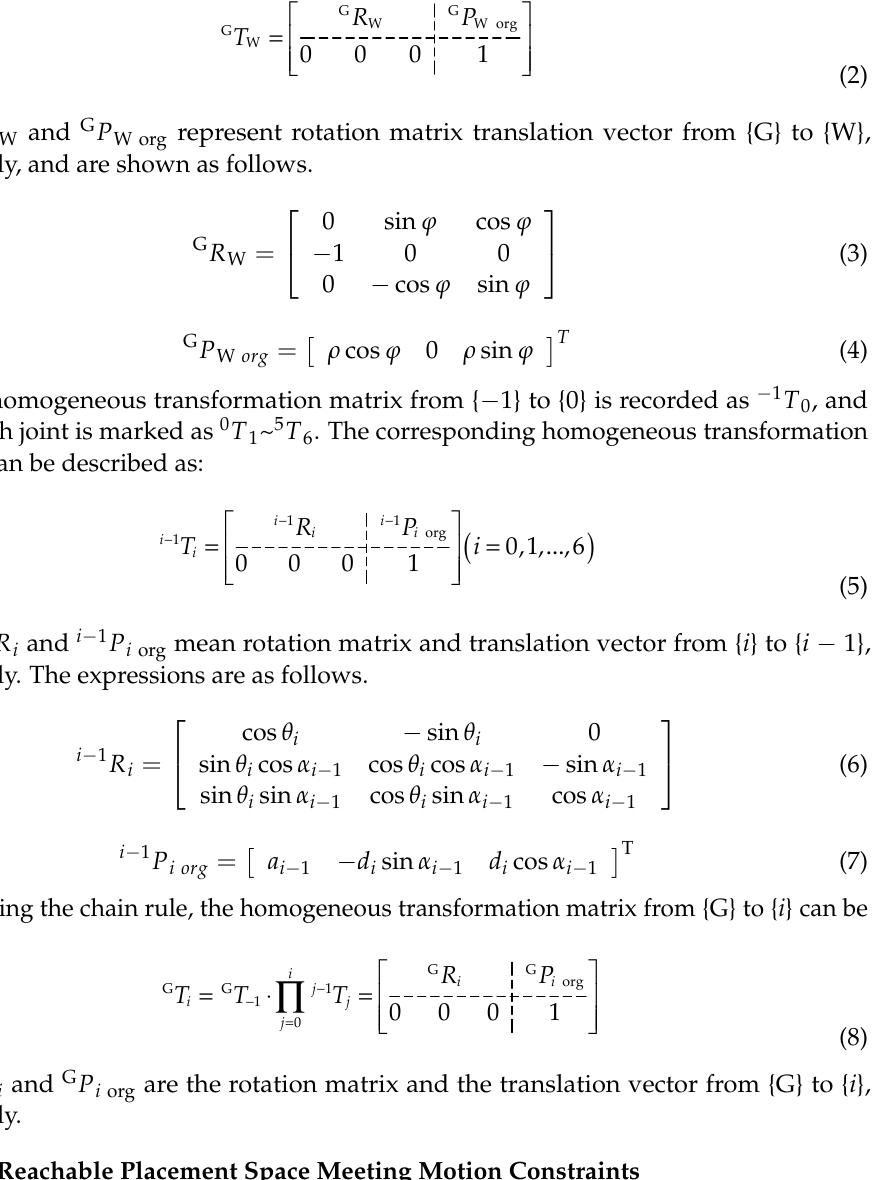
Figure 2. Coordinate systems of the flexible machining